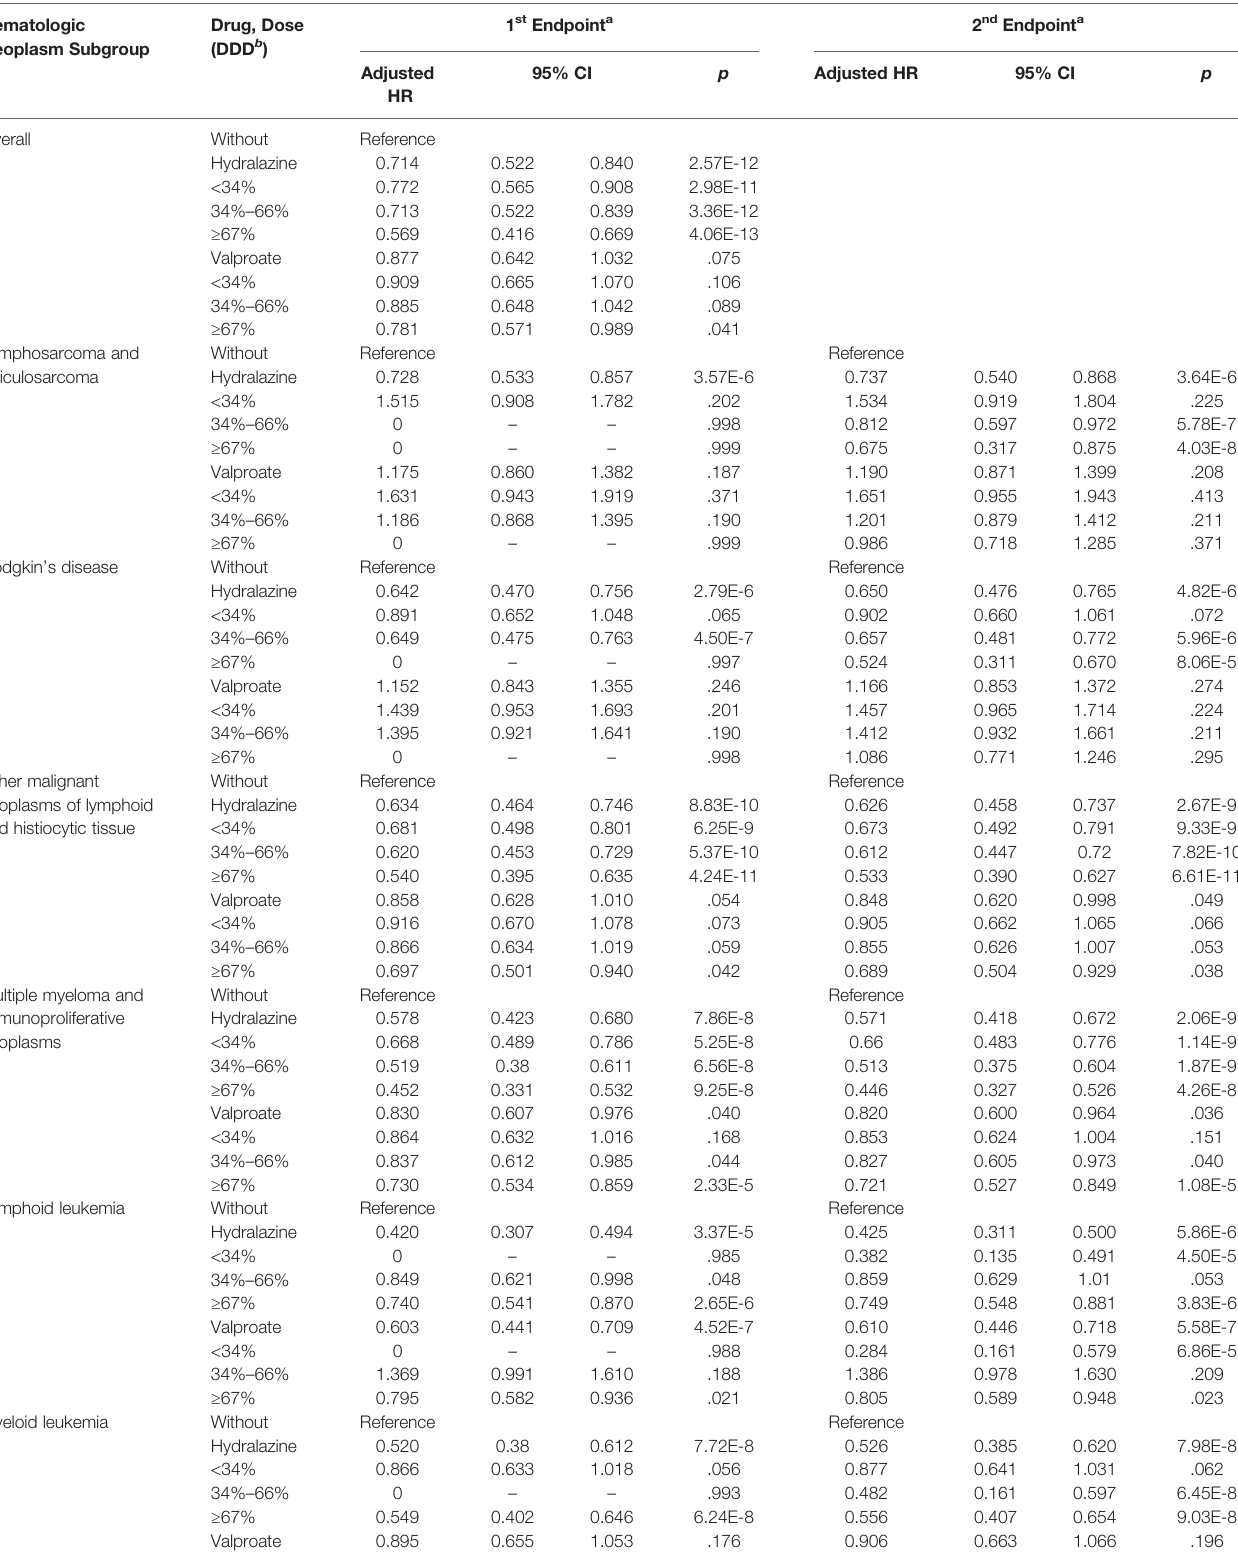
TABLE 1 | Adjusted HR of HN according to subgroup strati fi ed by dose level of HDZ and VAL. Hematologic Neoplasm Subgroup